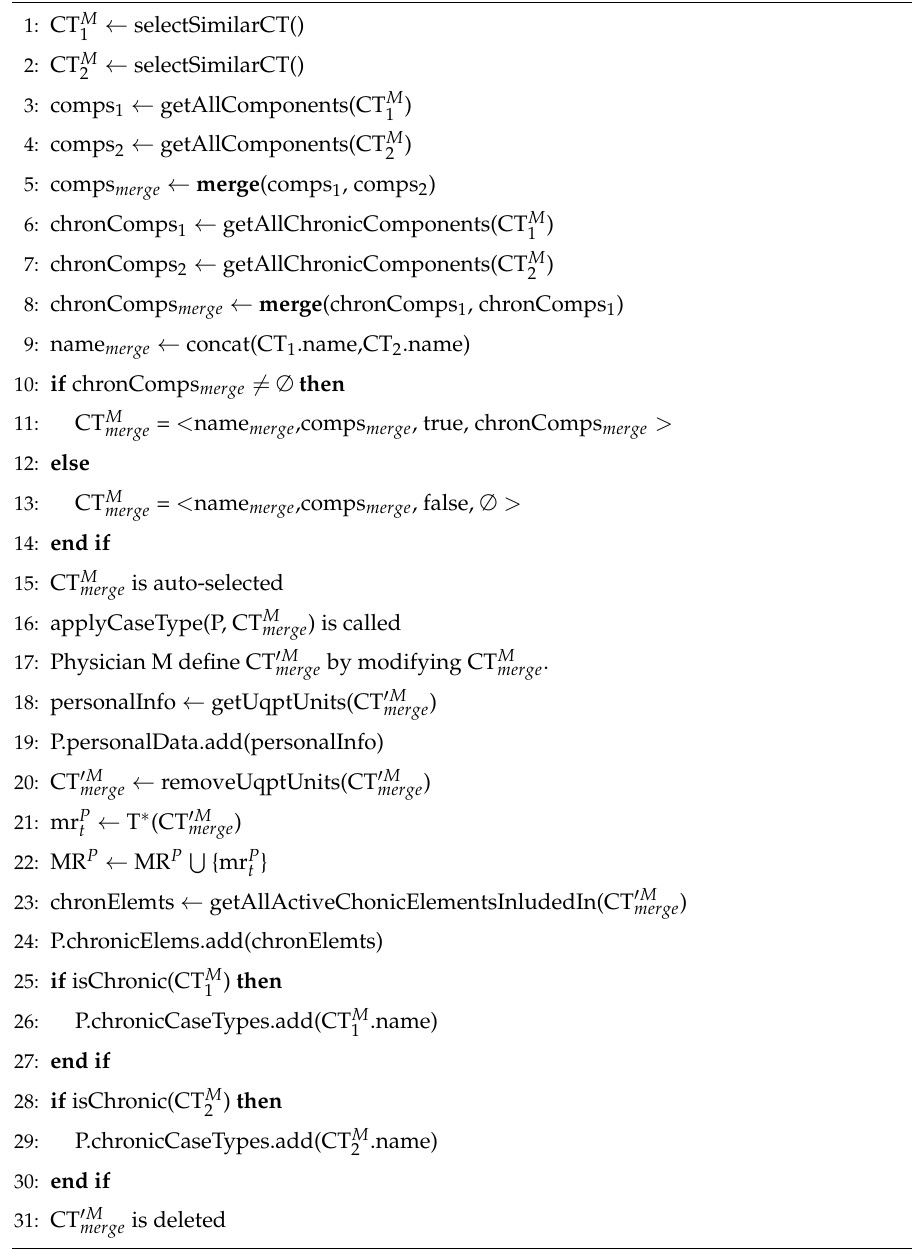
Algorithm 8 Multiple case types flow for the attention of patient